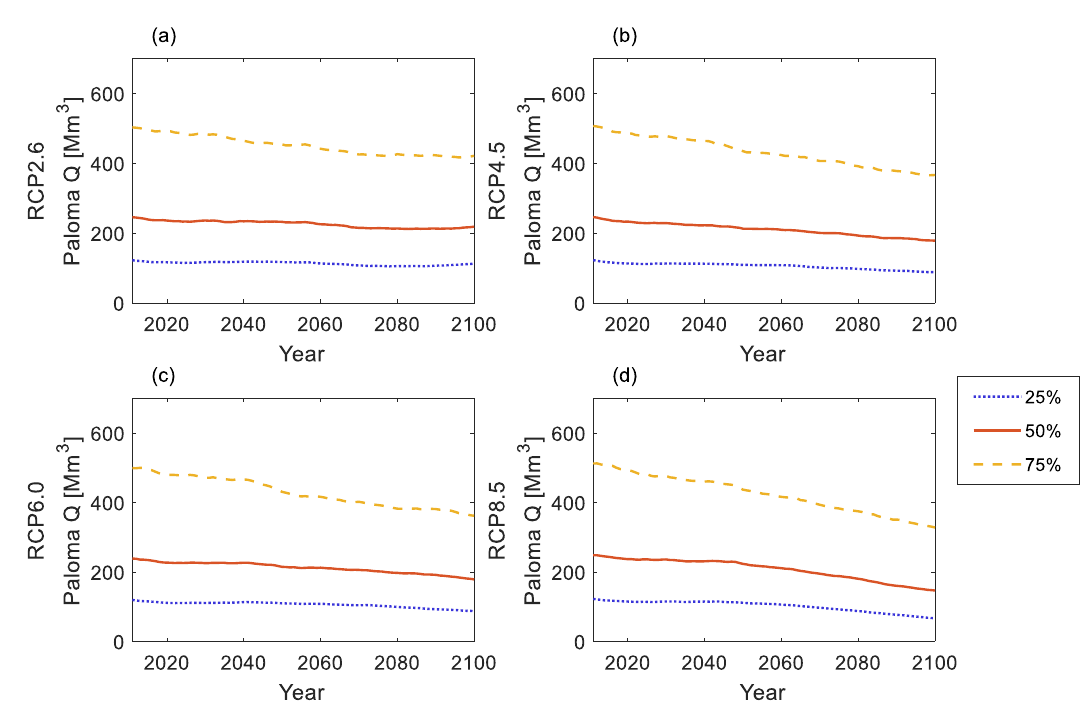
Figure 5. Projected inflow to the Paloma reservoir under RCP 2.6 ( a ), 4.5 ( b ), 6.0 ( c ), and 8.5 ( d ). The 25th (dotted line), 50th (solid line), 75th (dashed line) of annual inflows to the Paloma reservoir are averaged over a 40-year moving window, with the horizontal axis being the last year of the window.